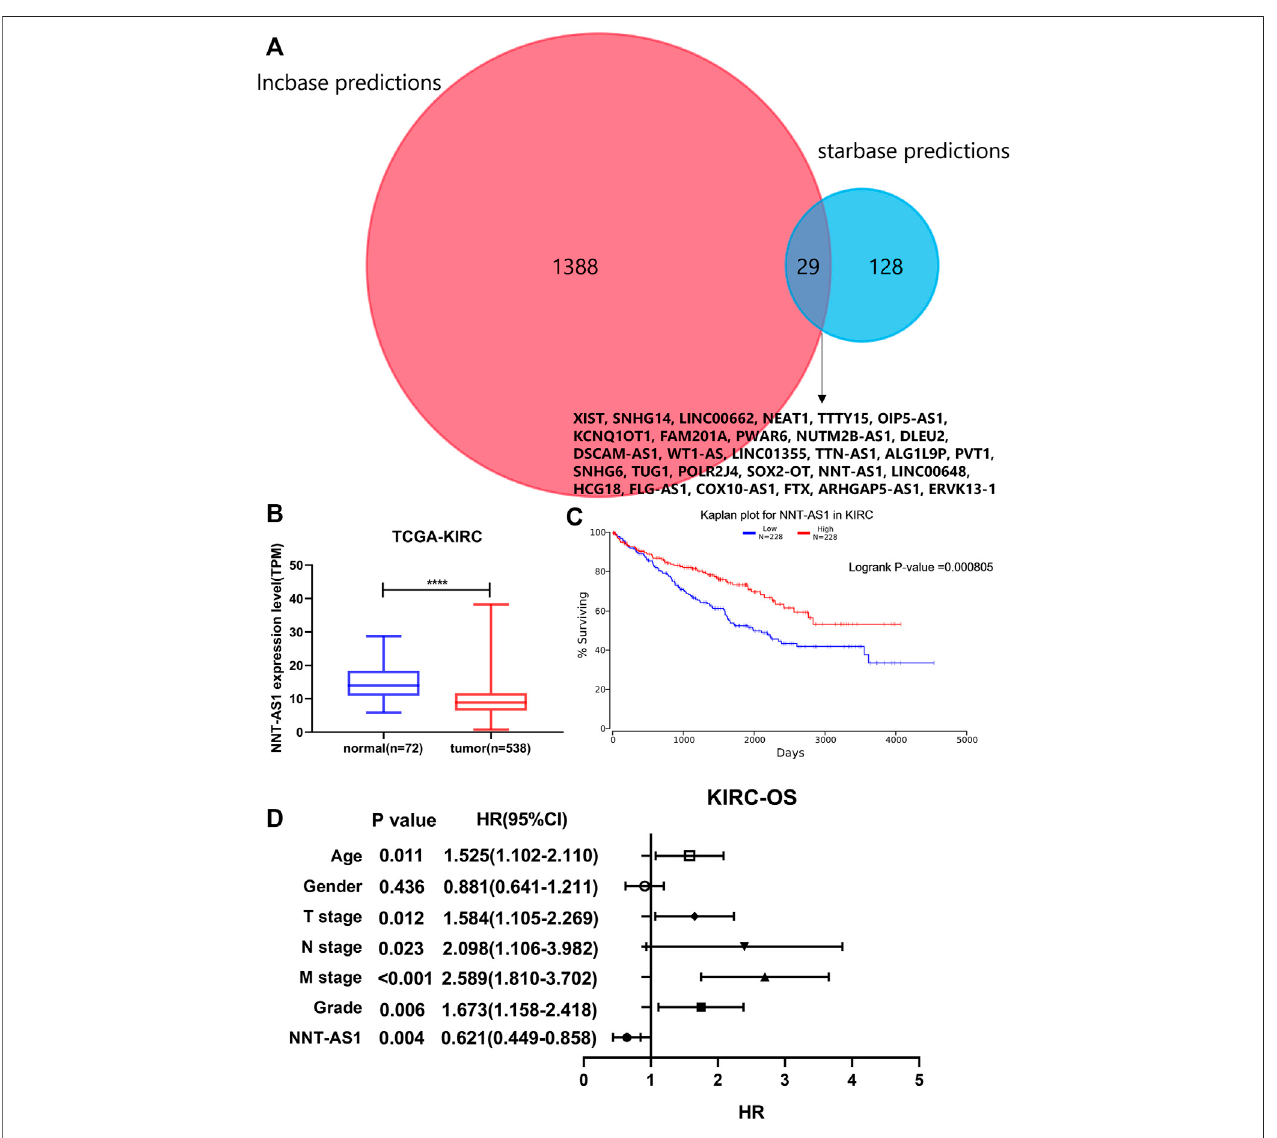
FIGURE 7 | Prediction of lncRNA. (A) Intersection of predicted lncRNAs from two online databases. (B) NNT-AS1 expressed much lower in ccRCC samples. (C) LowexpressionofNNT-AS1indicatedapoorersurvivalrate. (D) MultivariatecoxproportionalhazardregressionanalysisofNNT-AS1andotherknownriskfactors.NNT- AS1 acted as a protective factor for ccRCC, p (cid:1) 0.004.